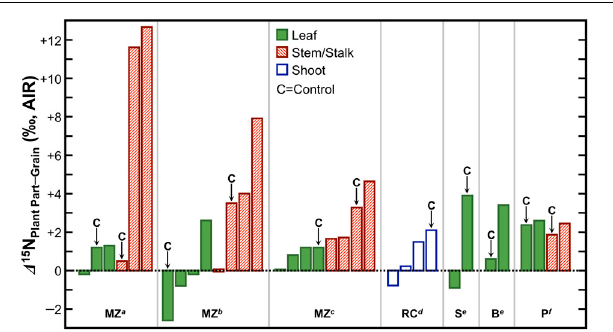
FIGURE 8 | Differences in δ 15 N between grains/fruits and above-ground plant parts. The grain or fruit tends to be depleted in 15 N relative to the leaves and stems/stalks. Data are from studies examining effects of fertilizers on plant δ 15 N values and a “C” above a particular bar denotes that these data are from a control treatment in which no fertilizer was applied. Abbreviations at the bottom of the figure denote species represented and source for data. MZ, maize; RC, rice; S, squash; B, bean; P, pepper. Data obtained from: a Szpak et al. (2012a), b Szpak et al. (2012b), c Choi et al. (2002), d Yun et al. (2011), e Szpak et al. (2014), f Del Amor et al.